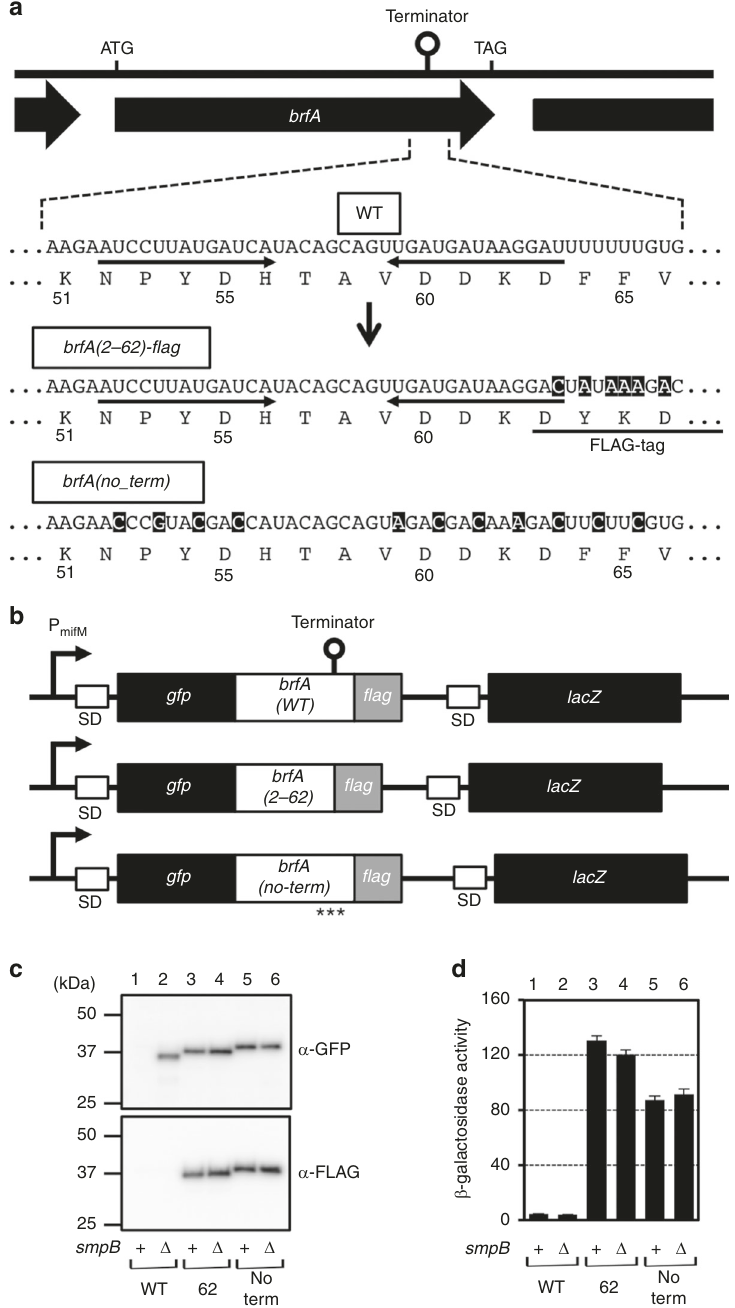
Fig. 2 The cellular abundance of BrfA is negatively regulated by trans- translation. a A schematic representation of the brfA open reading frame, showing the intrinsic transcriptional terminator sequence within the coding region (indicated by “ terminator ” at the top and the wild type (WT) enlarged view below). Shown also are the corresponding sequences of the gfp-brfA(2 – 62)- fl ag and gfp-brfA(no_term)- fl ag constructs (see b ), in which nucleotide substitutions and the FLAG tag are indicated by reverse and underline, respectively. b Schematic representations of the gfp-brfA- fl ag constructs with wild-type terminator sequence ( gfp-brfA(2 – 71)- fl ag ) and its derivatives with defective terminator signals. These gfp-brfA derivatives were placed under the constitutive mifM promoter. The lacZ gene is also placed downstream of the gfp-brfA derivatives. “ SD ” and asterisks indicate Shine-Dalgarno sequence and synonymous mutations, respectively. c Cellular accumulation of the products of the wild-type construct (lanes 1, 2) as well as the brfA(2 – 62) (lanes 3, 4) and the brfA (no_term) (lanes 5, 6) constructs. They were expressed in the smpB + (odd numbers) or the Δ smpB (even numbers) strains and analyzed by anti-GFP (upper) or anti-FLAG (lower) immunoblotting. d β -Galactosidase activities (mean± s.d., n = 3) of the cells horbaring lacZ at the downstream of wild type (columns 1, 2), the brfA(2 – 62) (columns 3, 4), or the brfA(no_term) (columns 5, 6) derivatives of the gfp-brfA in the presence (odd numbers) or absence (even numbers) of smpB . “ s.d. ” indicates standard deviation. Source data are provided as a Source Data fi